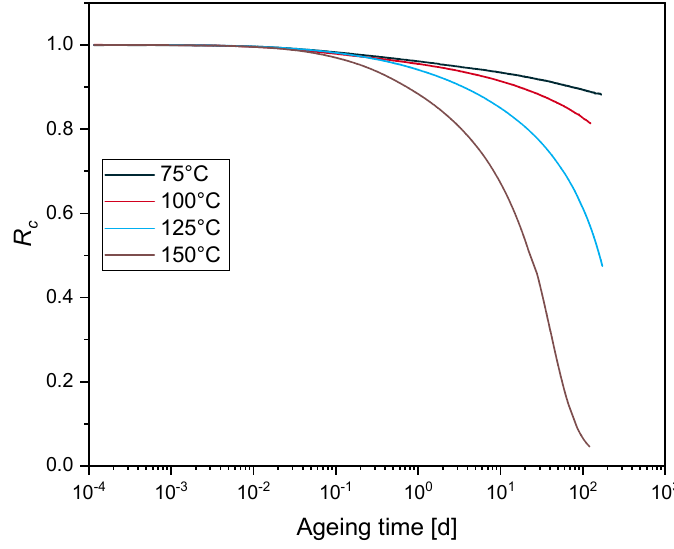
Figure 1. EPDM normalized continuous stress relaxation ( R c ) data at different temperatures.